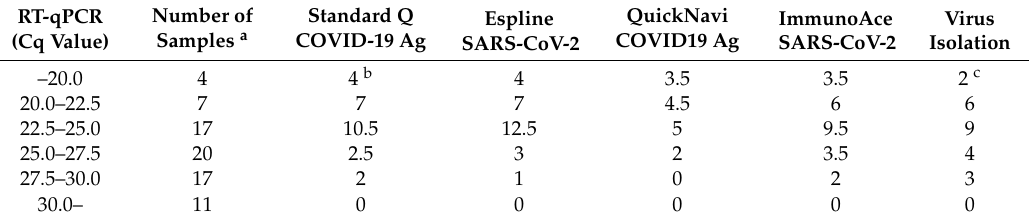
Table 2. Sensitivity of rapid antigen tests for clinical specimens.